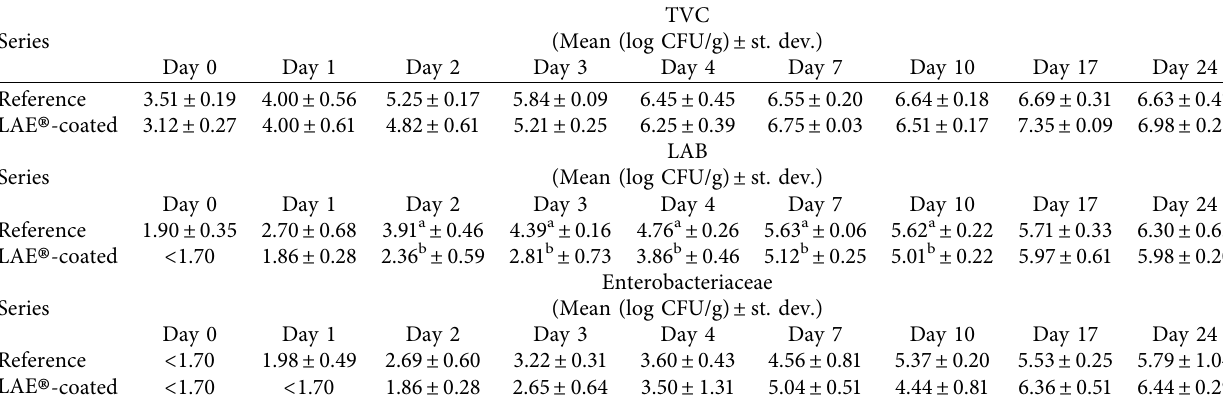
Table 1: Mean TVC, LAB, and Enterobacteriaceae counts obtained in reference and LAE ® -coated beef samples during the trial. Series